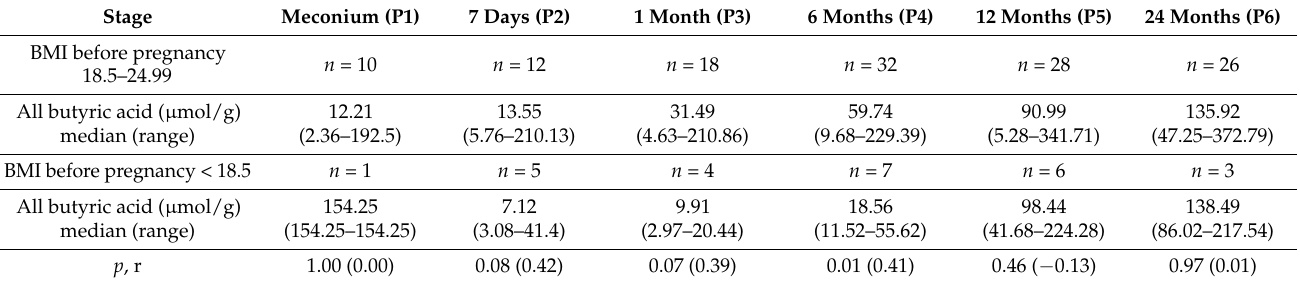
Table 7. Effect of BMI before pregnancy on all butyrate content.